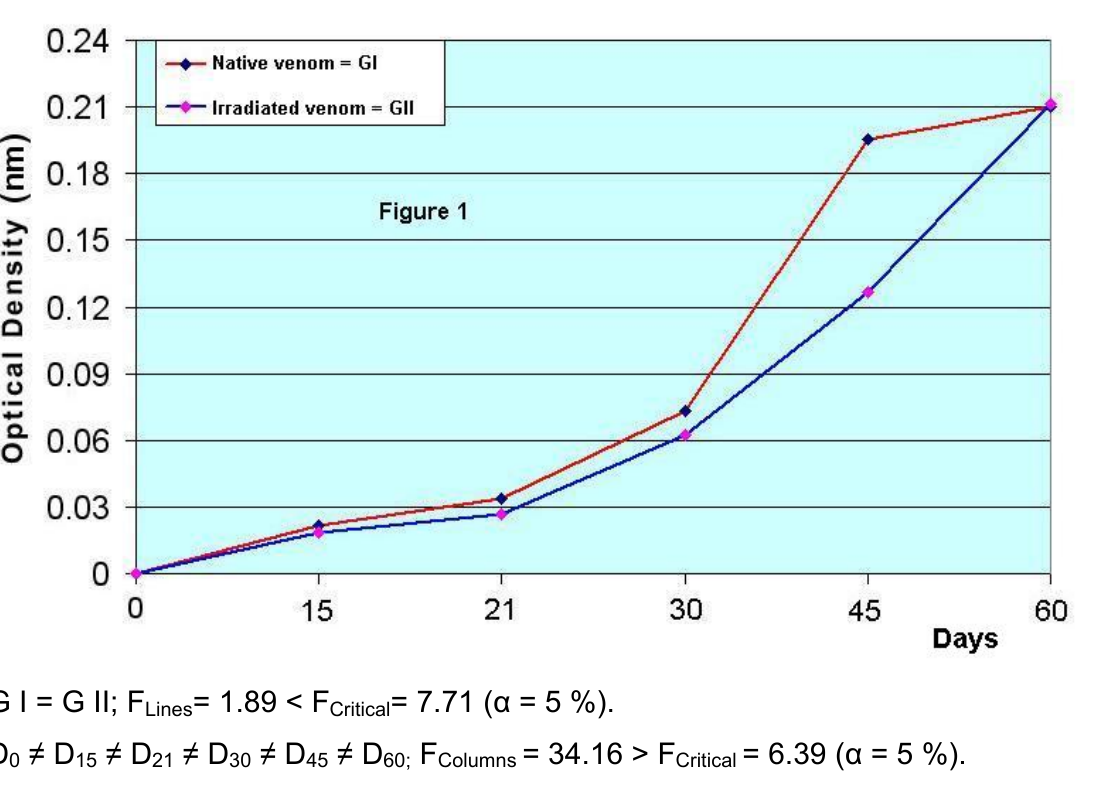
Figure 1: Distribution of the optical densities (nm) mean values in the ELISA test, in different moments, using serum extracted from animals inoculated with native (GI) and cobalt 60-irradiated (GII) venom, diluted in